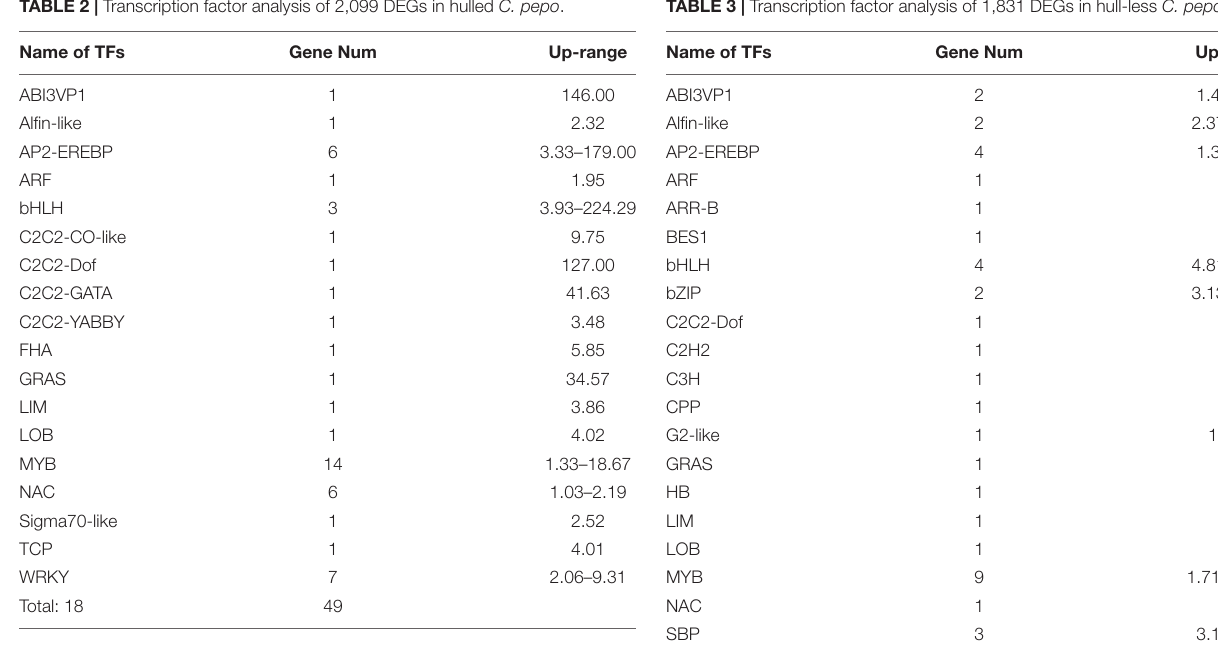
TABLE 2 | Transcription factor analysis of 2,099 DEGs in hulled C. pepo . TABLE 3 | Transcription factor analysis of 1,831 DEGs in hull-less C. pepo